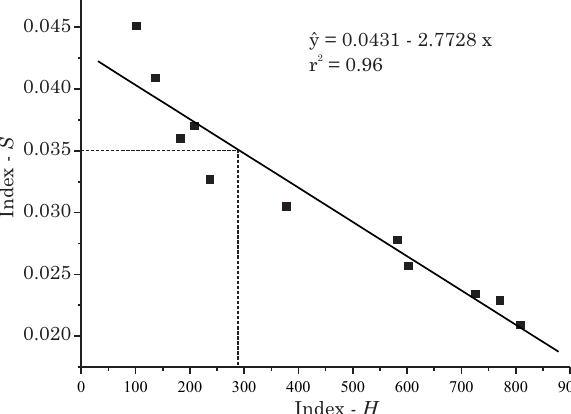
Figure 6. Illustration of negative linear dependence between the indexes S and H . The dashed line shows the S value of 0.035 and the corresponding H